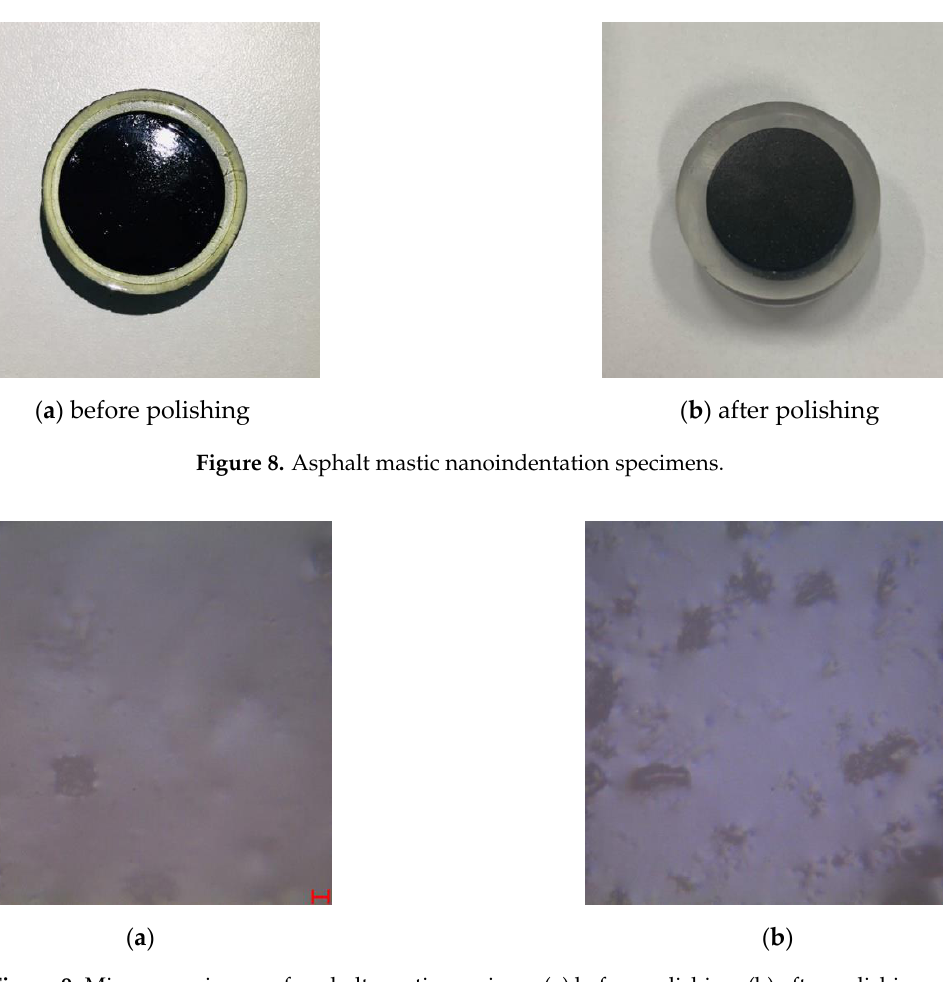
Figure 9. Microscope image of asphalt mastic specimen.(a) before polishing, (b) after